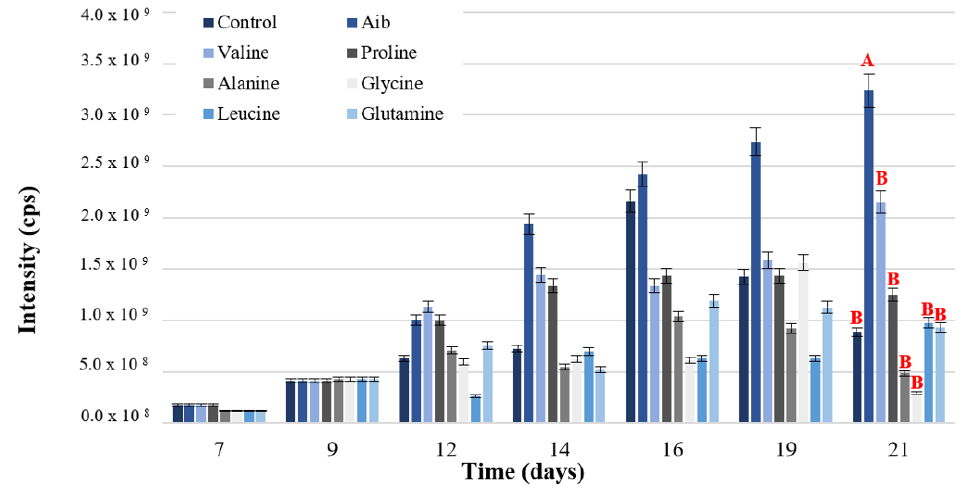
Figure 3. P aib production of T. asperellum according to the amino acid added to the culture medium. Intensity values on the left axis are relative to P aib production. Different letters represent significant differences between treatments.